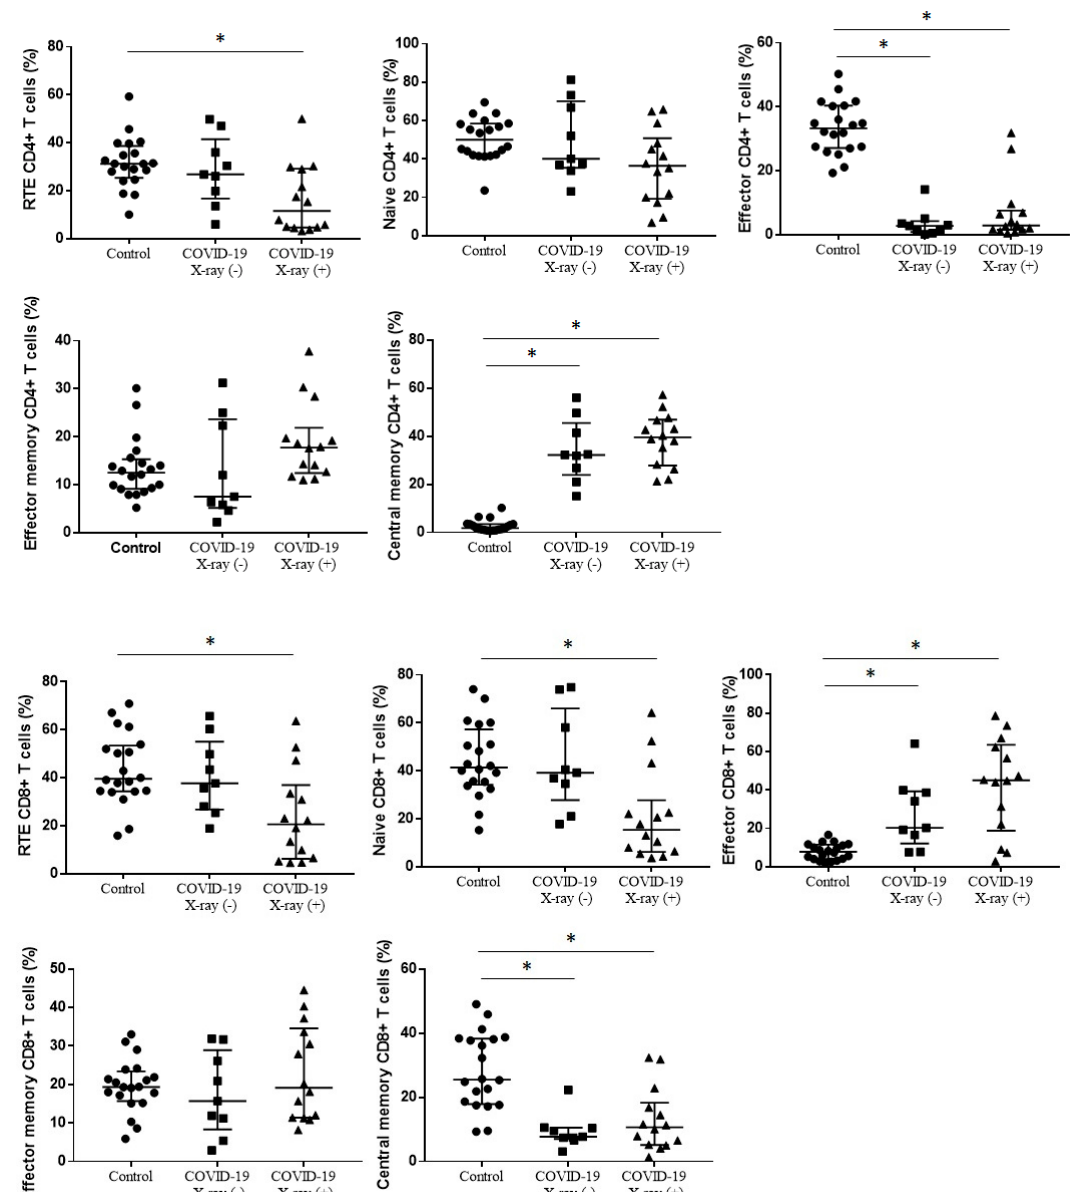
Figure 4. The differences in the median proportion of T lymphocytes maturation (CD4+ and CD8+) subsets: Recent thymic emigrants T cells (RTE), naïve T cells, effector T cells, central memory T cells and effector memory T cells between healthy patients (Control), patients with COVID-19 without interstitial lesions on chest X-ray (COVID-19 X-ray ( − )) and with interstitial lesions on chest X-ray (COVID-19 X-ray (+)). Graphs show the median values and quartile Q1-Q3 (* p < 0.05).